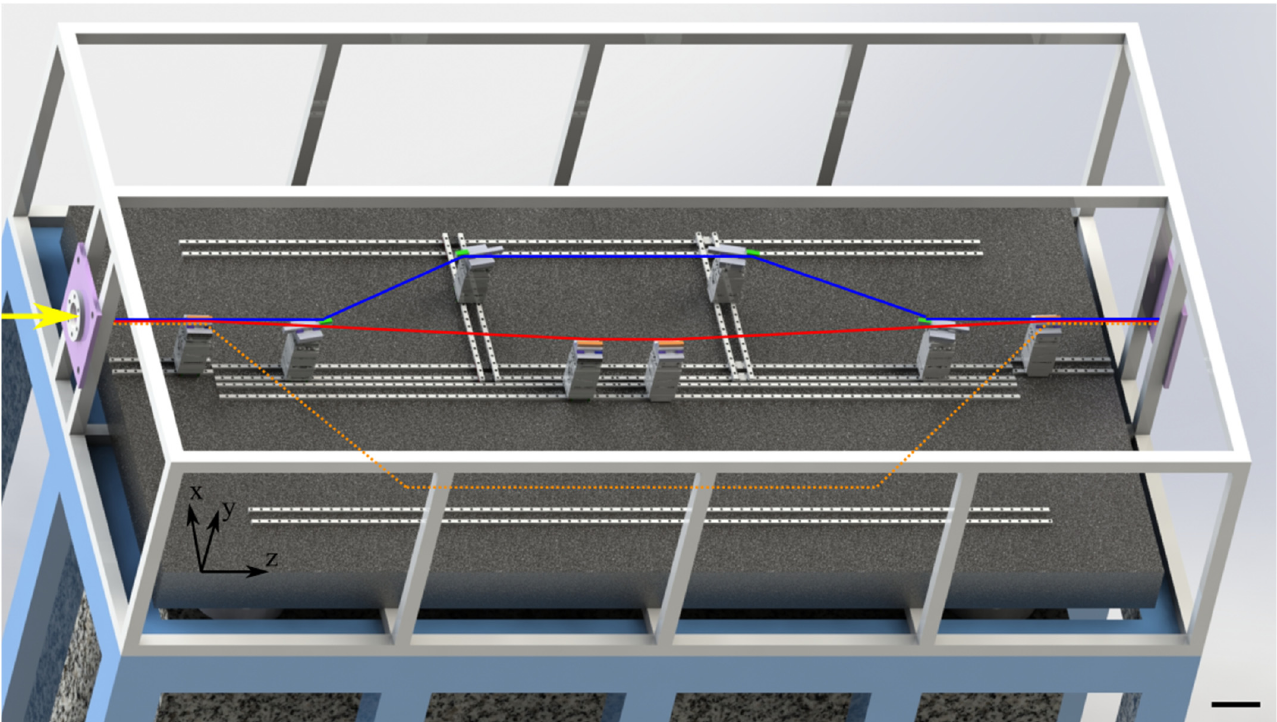
Figure 3. Illustrative mechanical layout of the hybrid SDL system. Colored lines are the paths of the (sub)pulses. The orange blocks illustrate the effective parts of the multilayers. Green blocks illustrate the effective parts of the crystals. The monitors and the attenuator are not shown for clarity. The black scale bar denotes 100 mm.